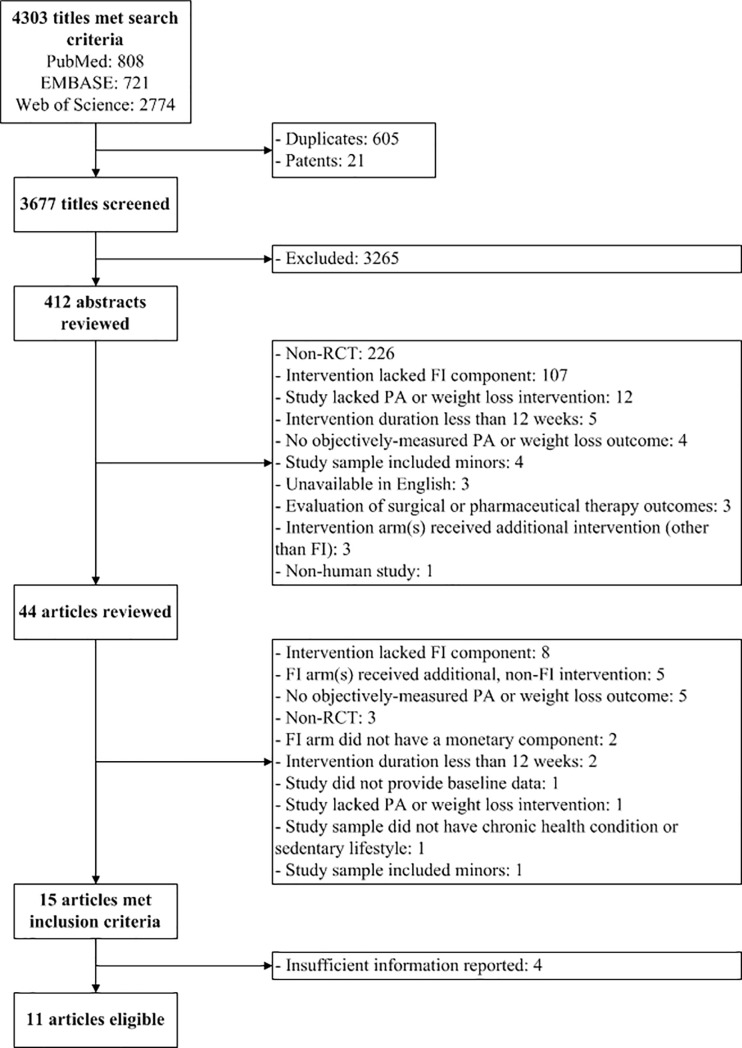
PRISMA flow consort diagram.[35].